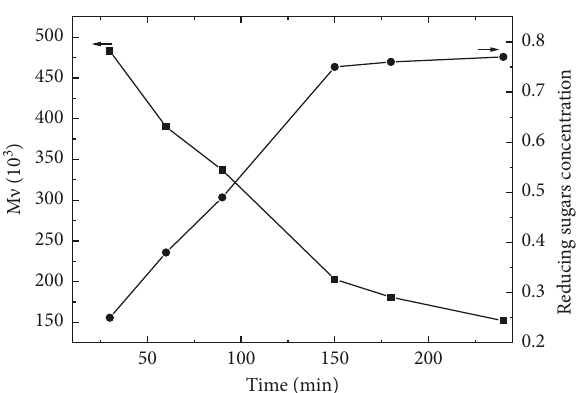
Figure 4: Effect of the time in the depolimerization developed by the enzyme